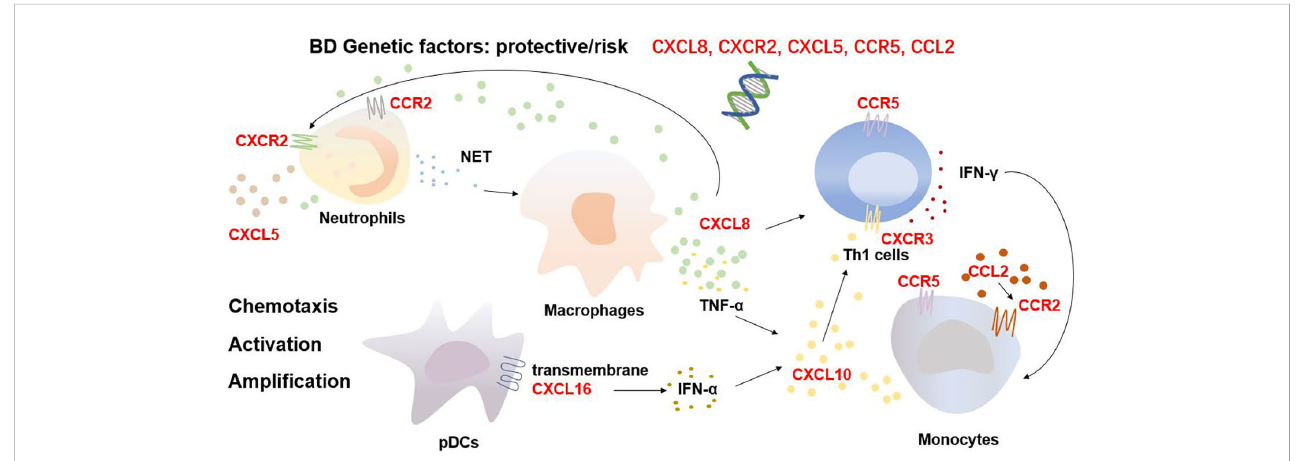
FIGURE 1 BD in fl ammatory microenvironment mediated by chemokines and chemokine